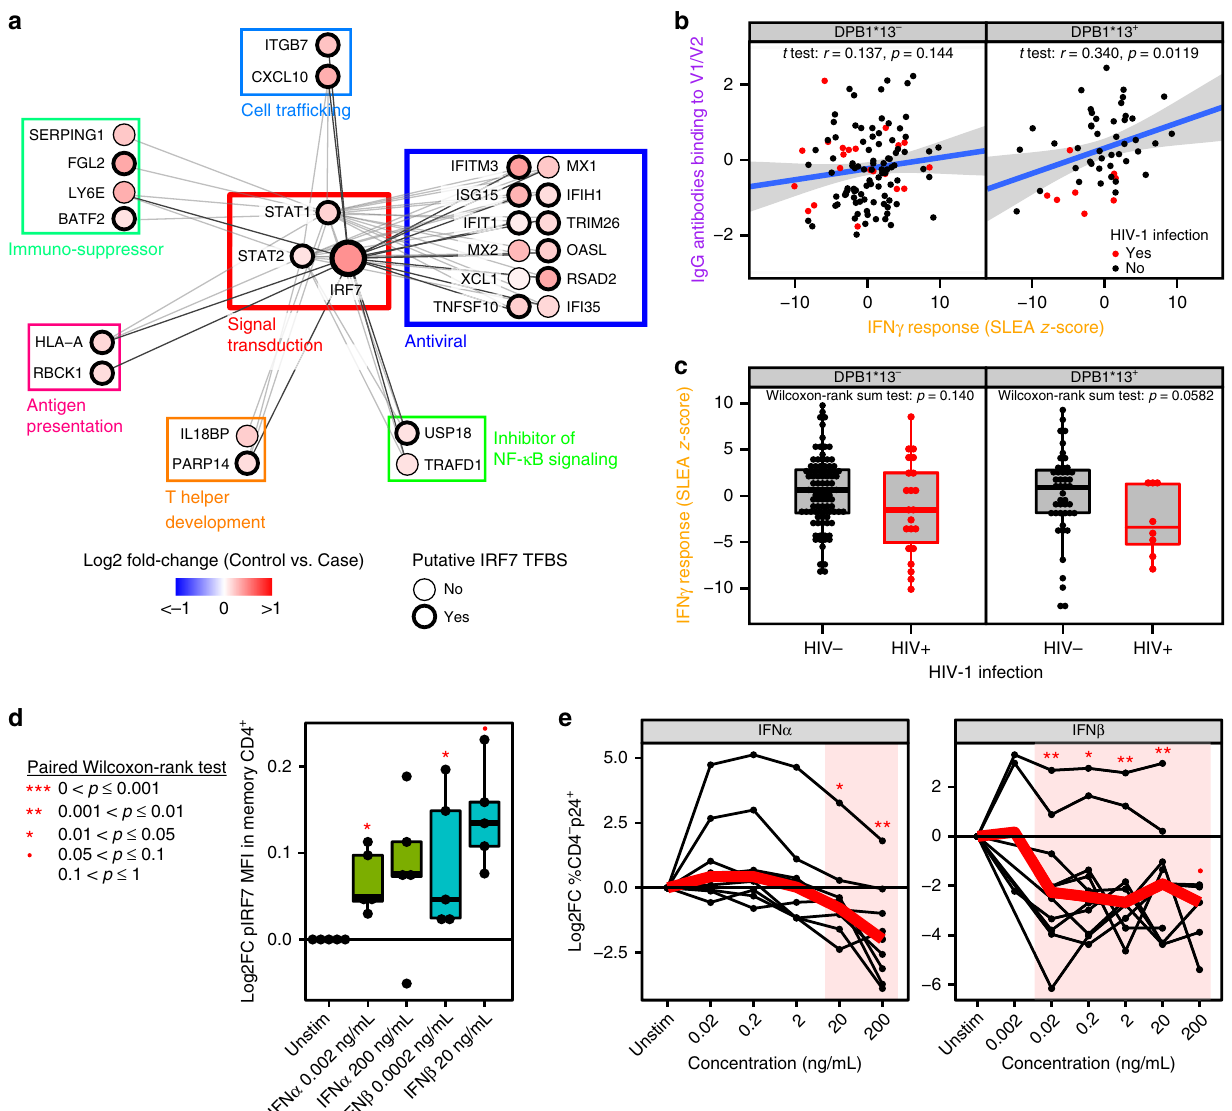
Fig. 5 Mechanisms associated with a reduced risk of HIV-1 acquisition among RV144 vaccinees. a Network showing the genes implicated in IFN γ signaling with annotated functions. Nodes correspond to genes; the color of a node is proportional to the log2 fold-change between controls and HIV-1 cases. Edges are inferred by GeneMANIA and correspond to physical interactions, colocalization, or co-expression. The remaining genes part of this signature but with unknown/unrelated functions can be found in Supplementary Data 5. b Scatter plot presenting the expression of IFN γ responsive genes as a function of the levels of IgG antibodies binding to V1/V2 and DPB1*13 alleles. The average expression of the IFN γ genes was calculated using the SLEA z -score method. A linear regression model (blue line), and its 95% con fi dence interval (gray zone), was fi t between SLEA z -score and IgG antibodies against V1/V2, and this separately for each DPB1*13 allele. A Pearson correlation and a t test were performed to assess the signi fi cance of the correlation between